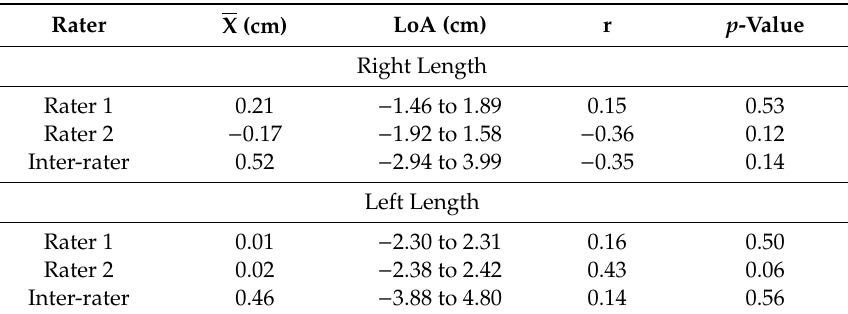
Table 4. Bland-Altman plot